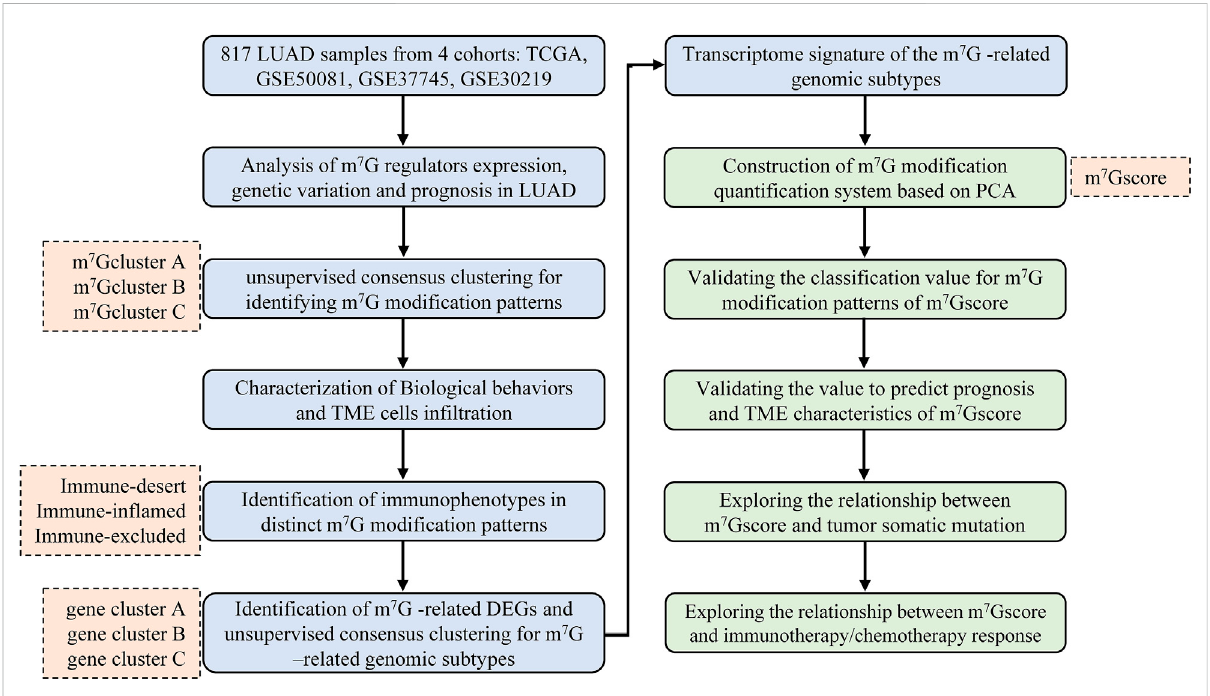
FIGURE 1 Overview of the study design and analytical fl ow. LUAD, lung adenocarcinoma; m 7 G, N7-methylguanosine; TME, tumor microenvironment; DEG, differentially expressed gene; PCA, principal component